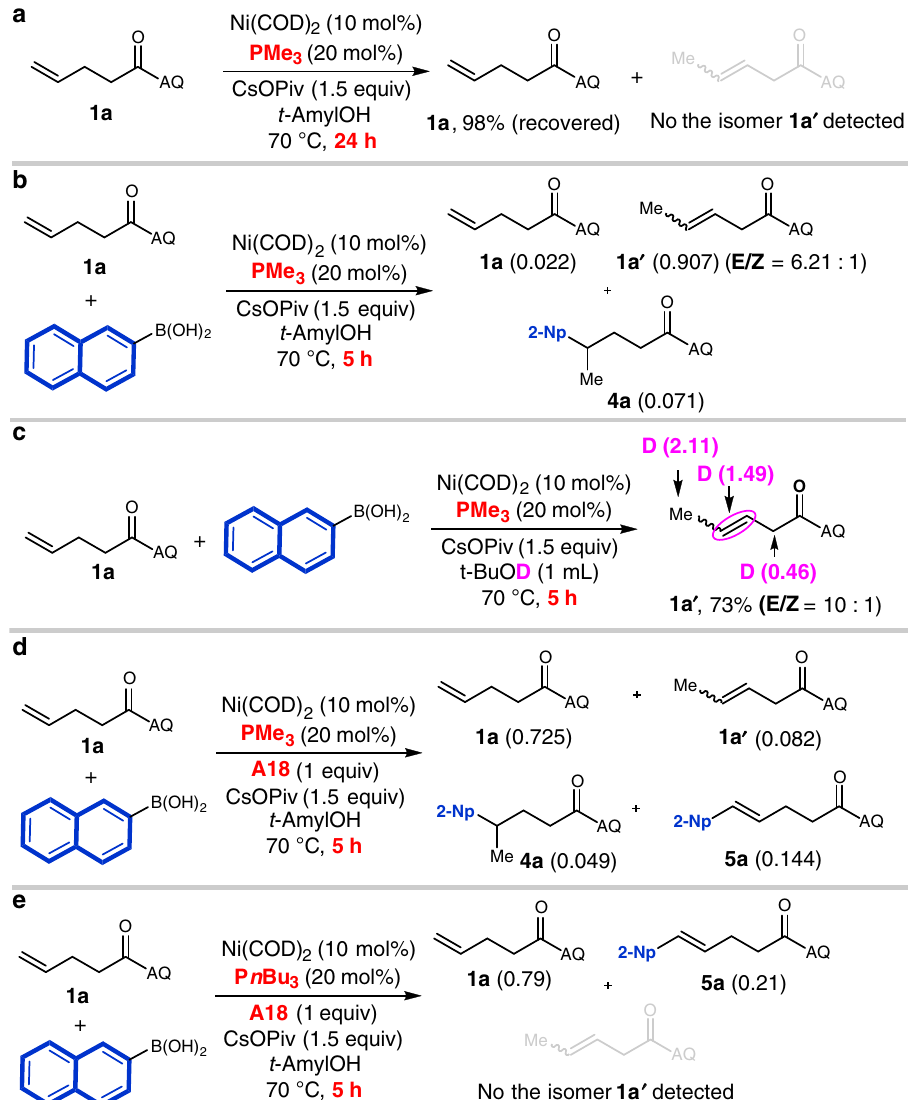
Fig. 4 A series of experiments to study the mechanism of the γ -selective hydroarylation. a The control experiment in the absence of arylboronic acid. b The monitoring of the alkene substrate in hydroarylation for 5 h. c Deuterium incorporation into isomerized alkene. d The hydroarylation reaction in the presence of the compound A18 for 5 h. e The reaction by use of P n Bu 3 as the ligand for 5